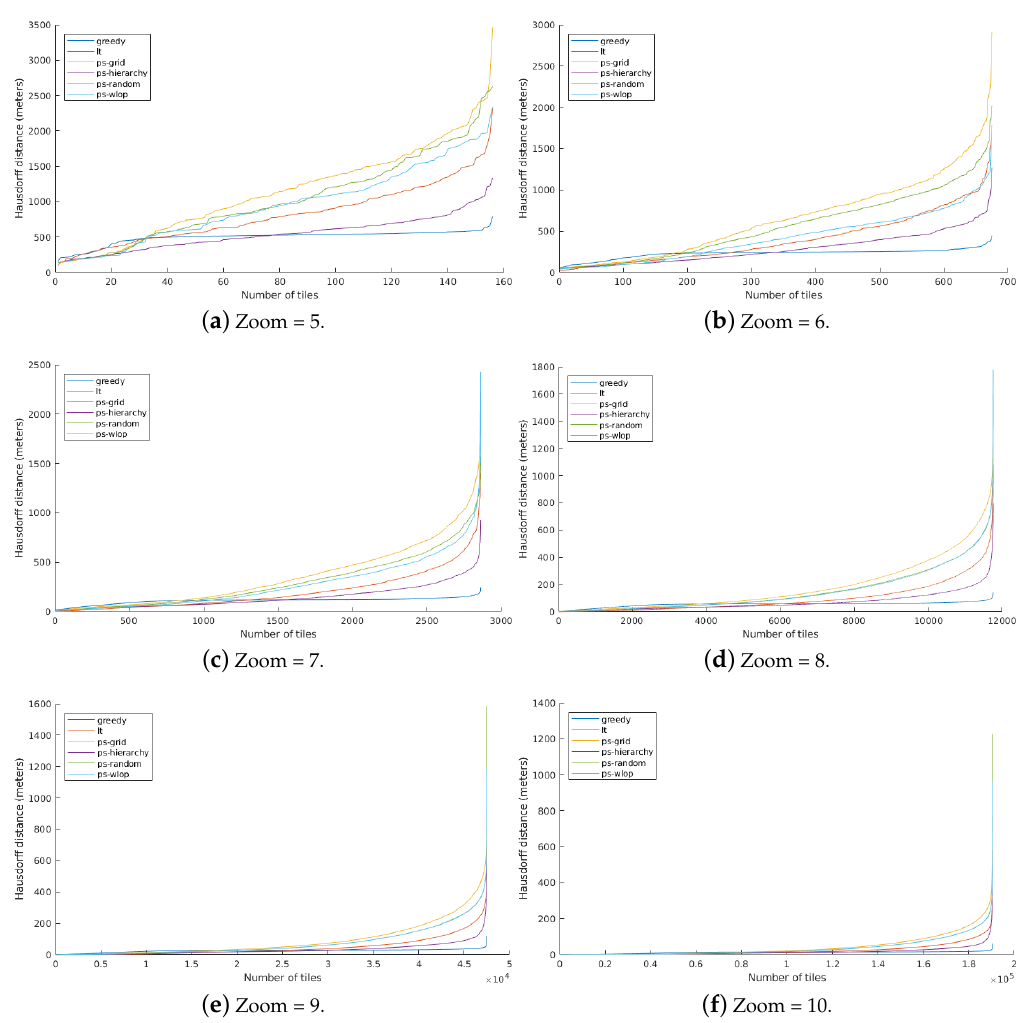
Figure 8. Sorted symmetric Hausdorff distances for all the tiles in zooms 5 to 10.